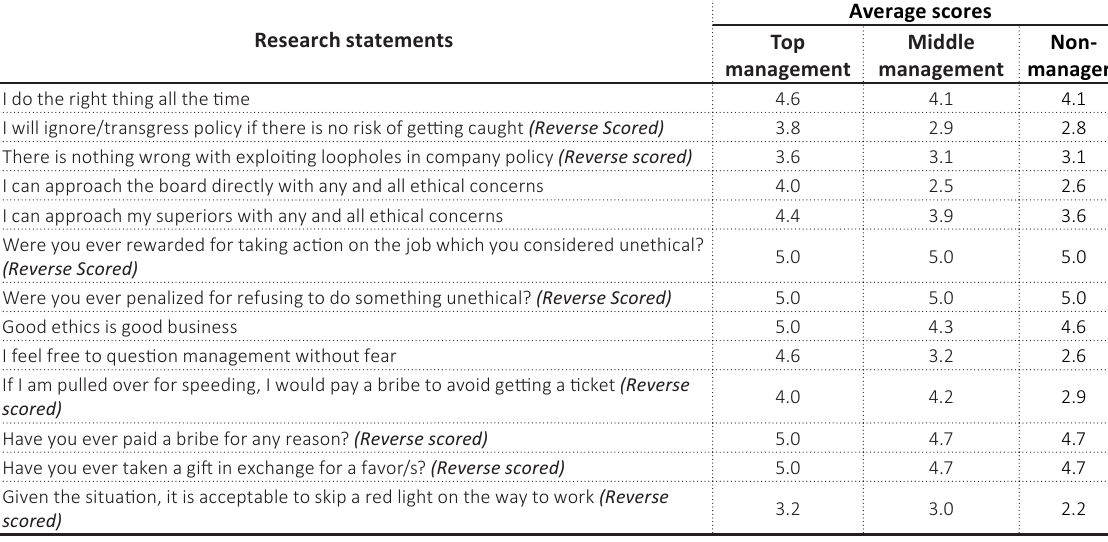
Source: Research